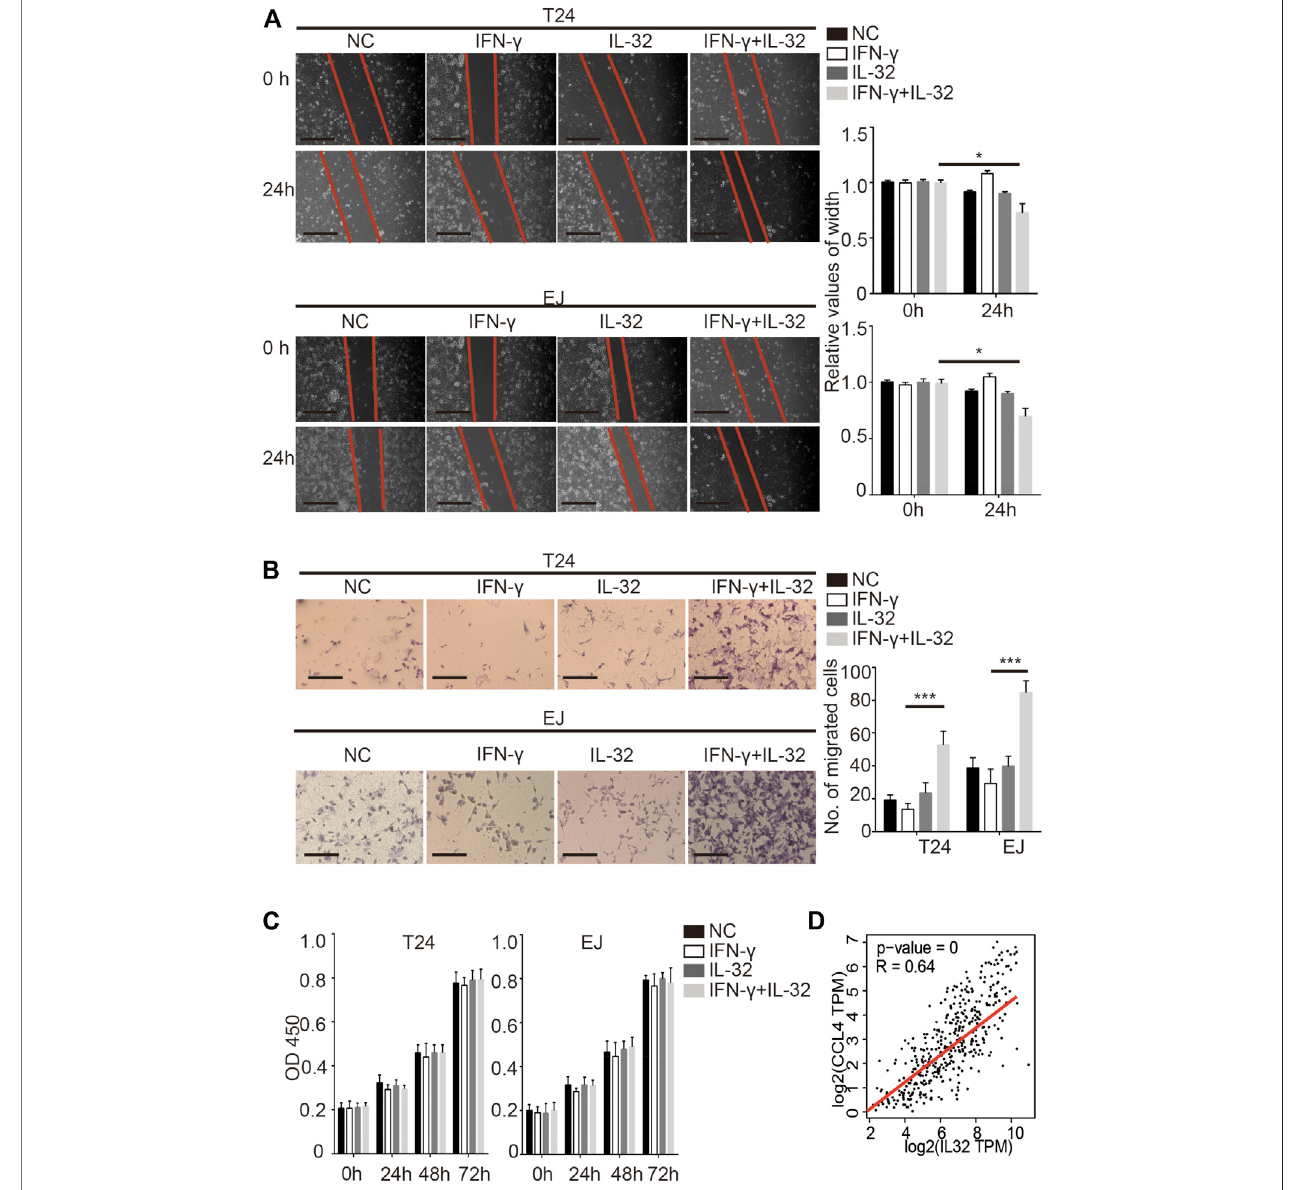
FIGURE 3 | IL-32 promotes the metastasis of bladder cancer. (A) IL-32 enhances the migration ability of bladder cancer cells. Representative data of 3 independentexperimentsfromwoundhealingmigrationassaysperformedwiththeindicatedbladdercancercells.Scalebar (cid:1) 100 μ m (leftpanel) .Therelativevaluesof widthareshownasthemean ± SD.* p < 0.05;one-wayANOVA (rightpanel) . (B) IL-32increasestheinvasionabilityofbladdercancercells.Representativedataofthree independent experiments from crystal violet staining showing the invasive capacities of bladder cancer cells. Scale bar (cid:1) 100 μ m (left panel) . The number of migrated cells is shown as the mean ± SD. *** p < 0.001; one-way ANOVA (right panel) . (C) IL-32 does not disrupt the proliferation of bladder cancer cells. Cell viability wasmeasuredusingtheCCK8assay.Dataareshownasthemean ± SD. (D) TheassociationbetweenIL-32andCCL4.TherelationshipbetweenIL-32andCCL4inthe TCGA and GTEx databases is shown. Spearman ’ s rank correlation coef fi cient is shown.